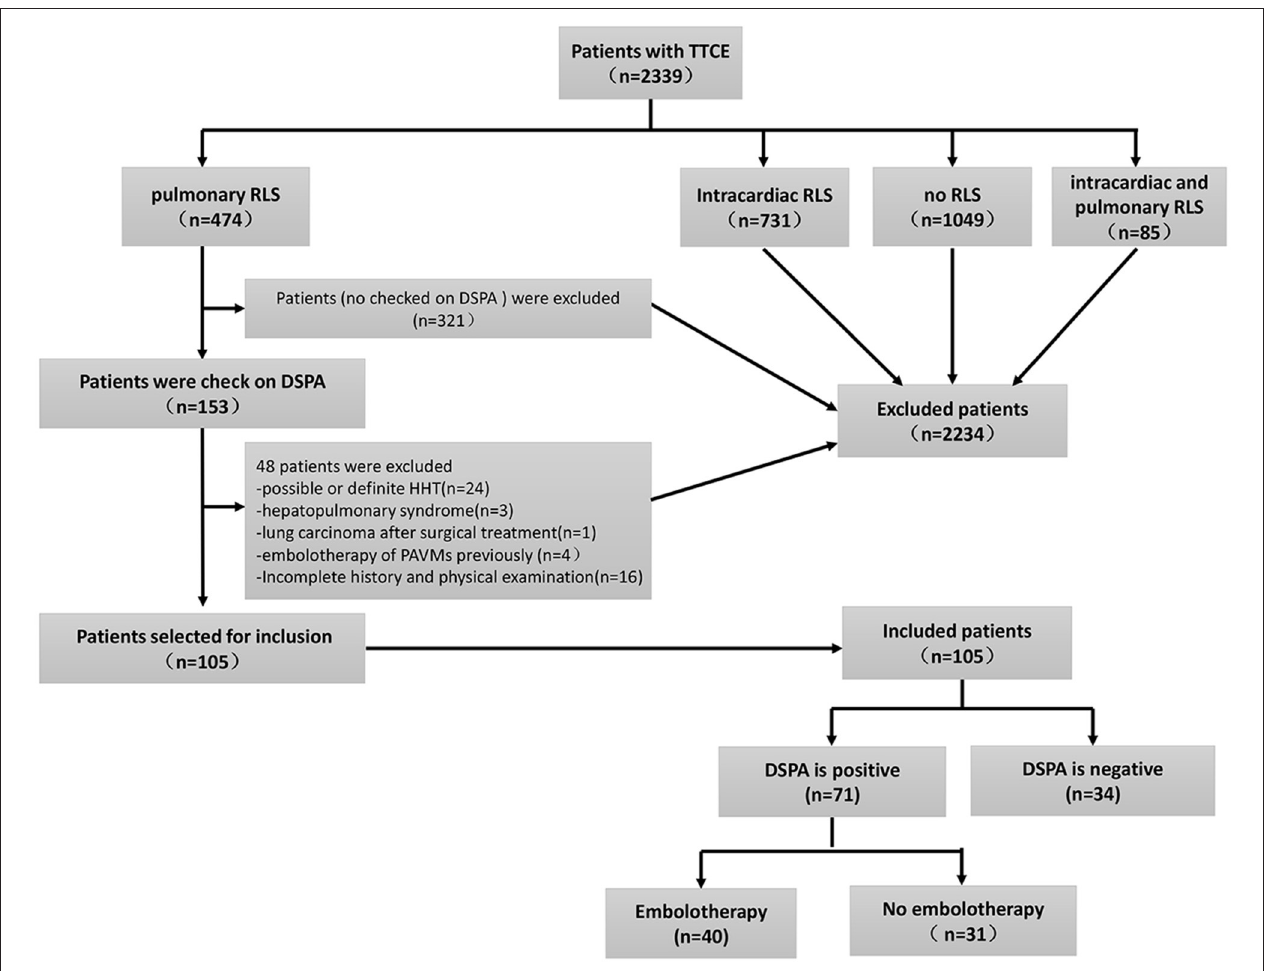
FIGURE 1 | The inclusion flowchart and group assignment of PAVMs patients. Other causes with insufficient clinical information ( n = 16, 13.5%). TTCE, transthoracic contrast echocardiography; RLS, right to left shuts; DSPA, digital subtraction pulmonary angiography.